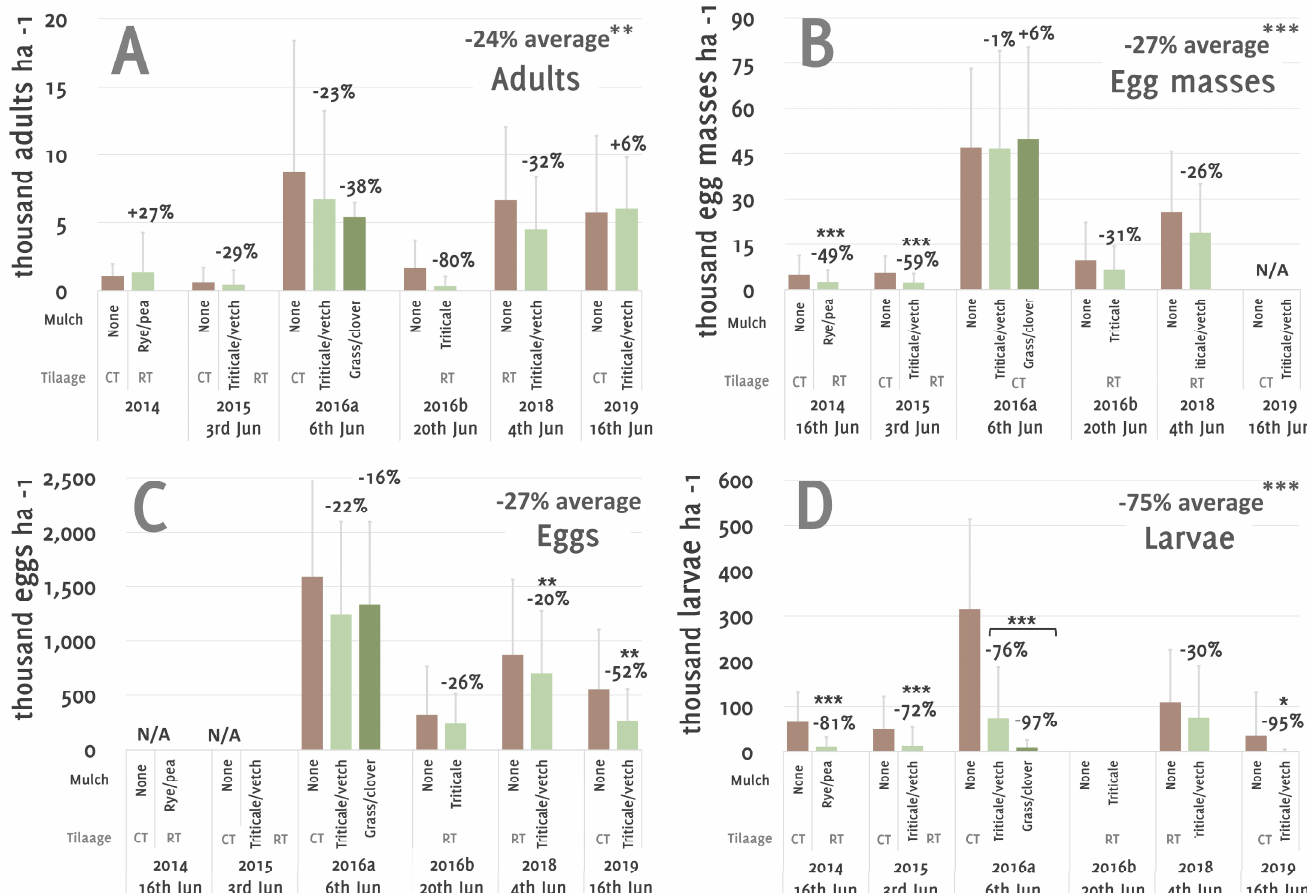
Figure 2. Effect of various mulch materials on different developmental stages ( A – D ) of CPB during initial infestation in the different experiments in mulched and unmulched variants under conventional (CT) and reduced (RT) tillage. Relative numbers (%) show the differences between the mulched and unmulched control. Lines above the bars indicate the positive standard deviation. Statistical differences are indicated by * ( p < 0.05), ** ( p < 0.001) and *** ( p < 0.0001).